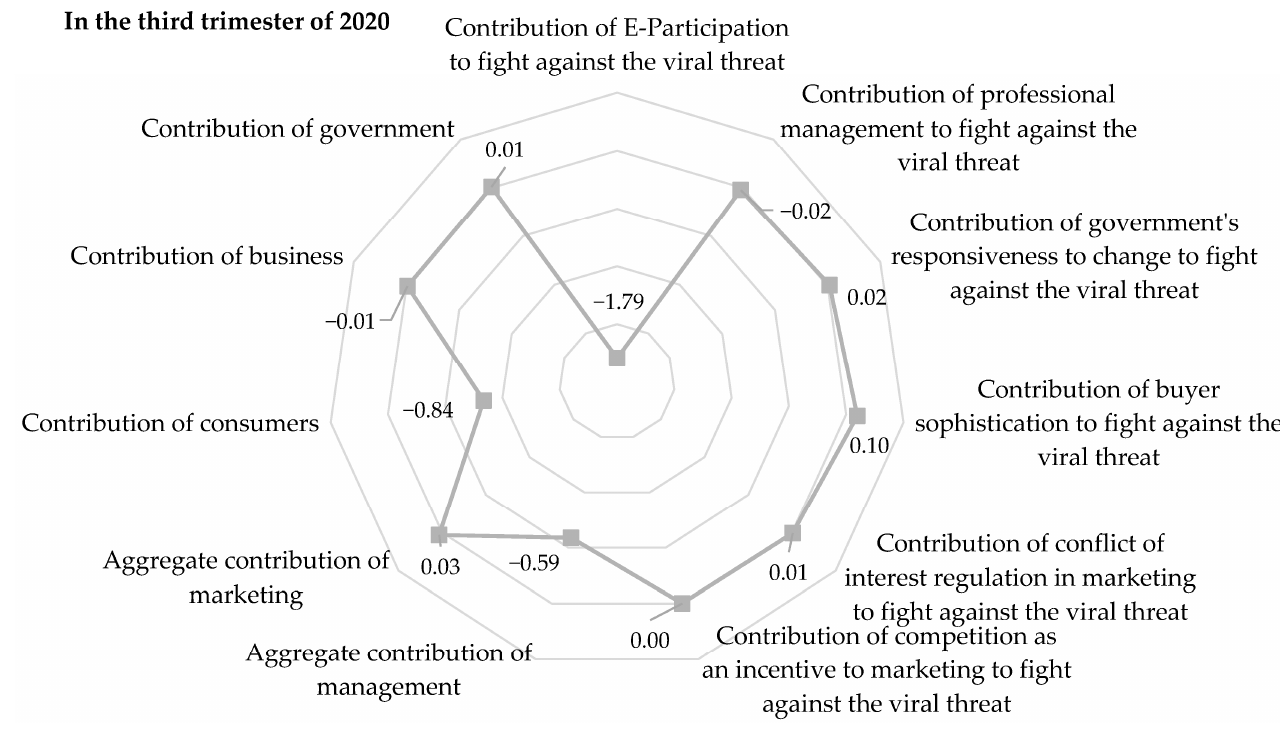
Figure 2. Contribution of management and marketing factors to the pandemic risk management in the third trimester of 2020. Source: Calculated and developed by the authors according to the dataset (Sozinova 2022).